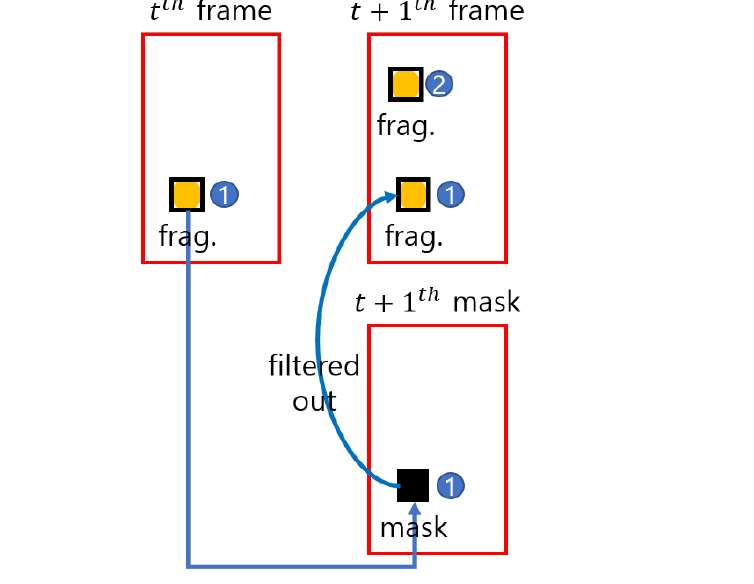
Figure 5. A toy example representing the difference between the bounding box generated by the Faster R-convolutional neural network (CNN) and mask obtained by the temporal